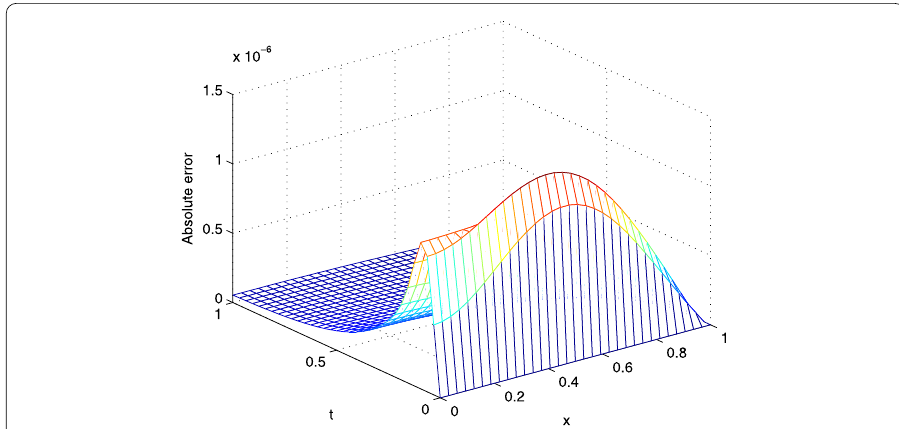
Figure 6 The global error for Example 4 with α = 0.8, h = 1/32, τ = 1/32